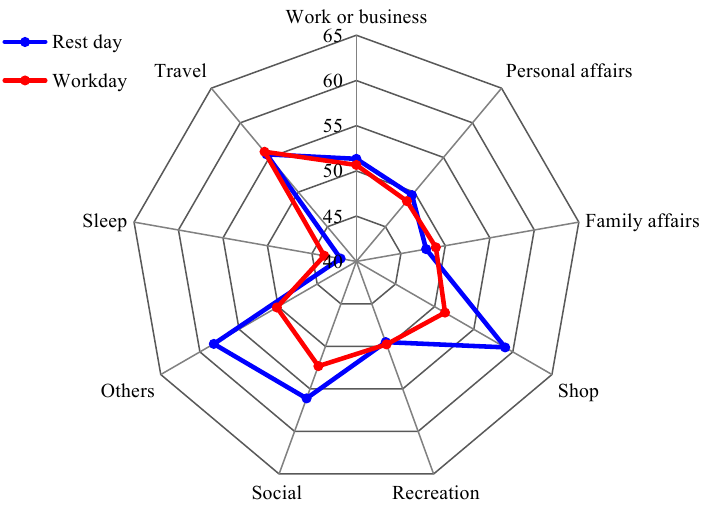
Figure 7. Noise exposure under different activity types on workdays and weekends.